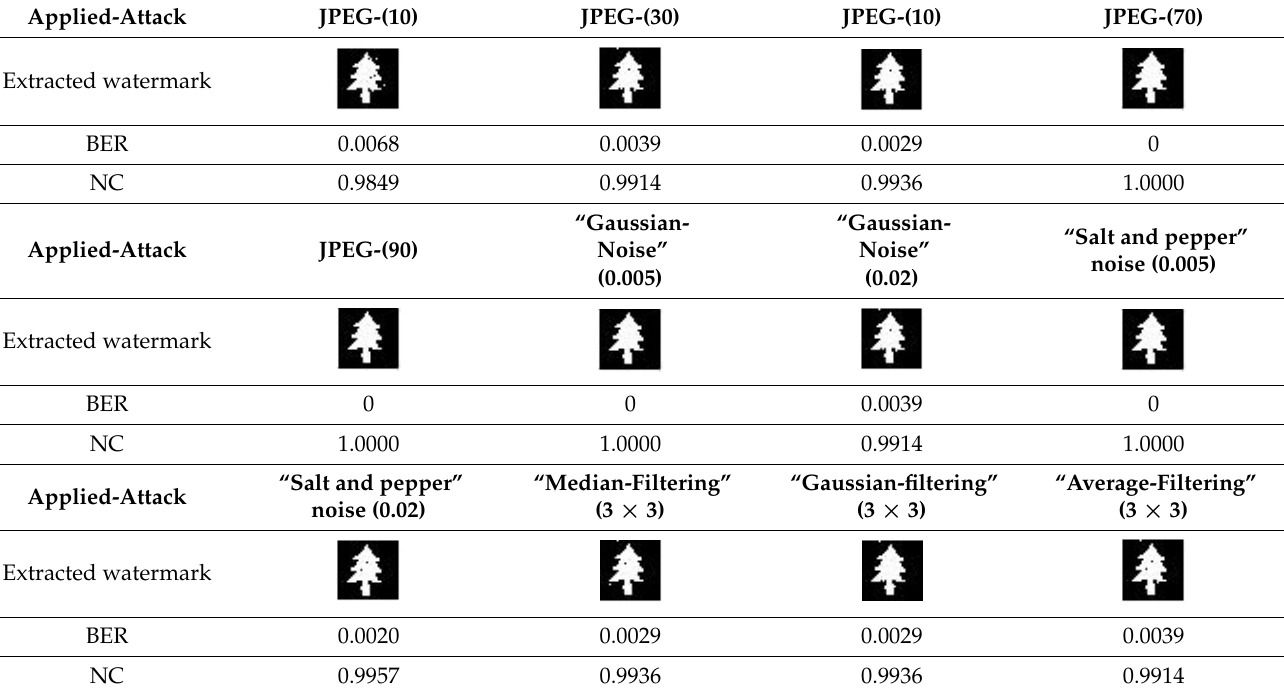
Table 2. The extracted watermarks and the corresponding BER and NC values under common image processing attacks.